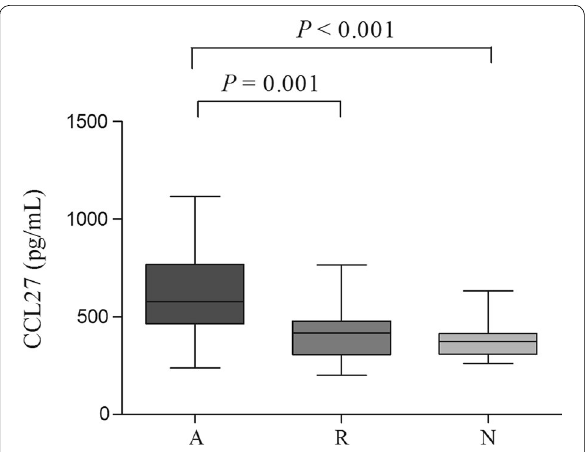
Fig. 1 Serum levels of CCL27 from SJS/TEN patients during the acute phase (lane A), SJS/TEN patients during the resolution stage (lane R), and normal subjects (lane N). Statistical significance was determined